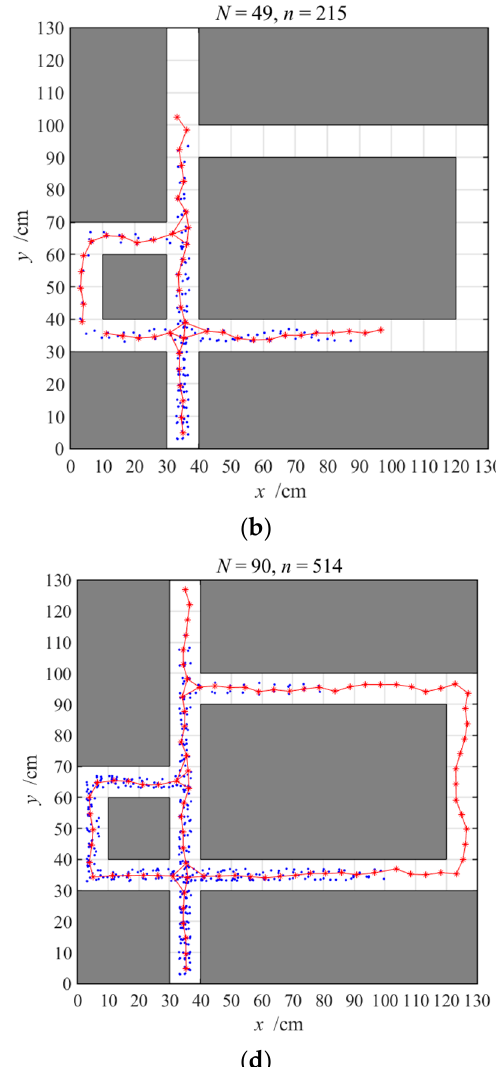
Figure 6. The generation process of the cognitive map; ( a – d ) are the cognitive maps when 24, 49, 74, and 90 place cells are activated, respectively. The reachable positions, the activated place cells and the links between them are marked by blue points, red asterisks and red lines, respectively. N at the top of each panel represents the number of activated place cells, and n represents the number of positions passed.